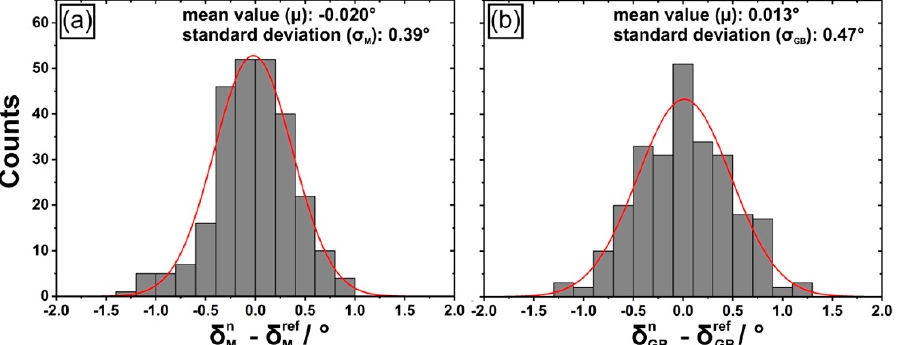
Figure 4. Precision of the applied orientation analysis. For details see text.